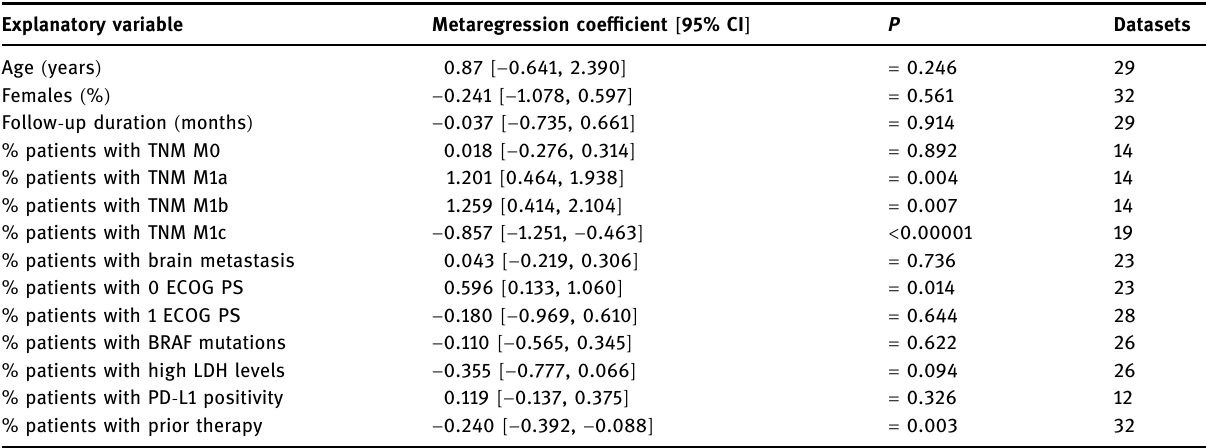
Table 1: Independent relationships of ORR with explanatory variables Explanatory